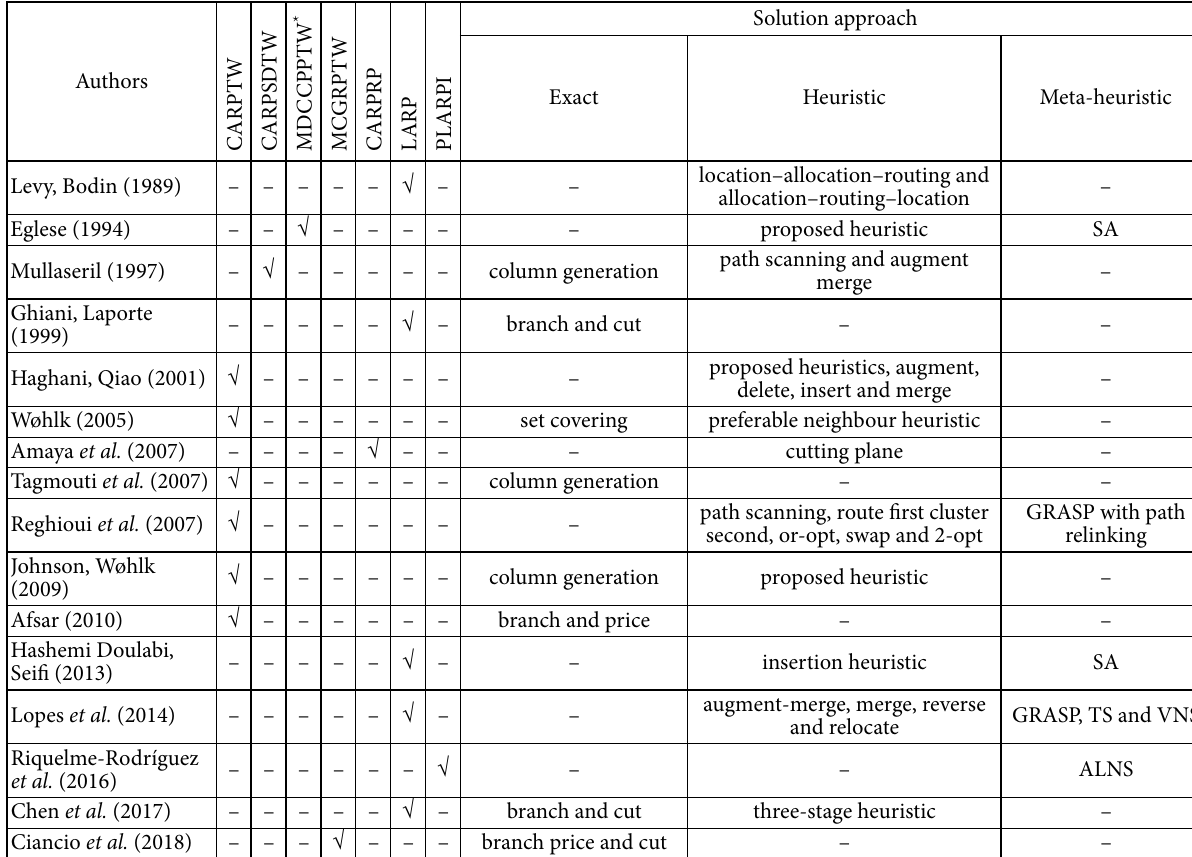
Table 1. A summary of previous related studies problem type